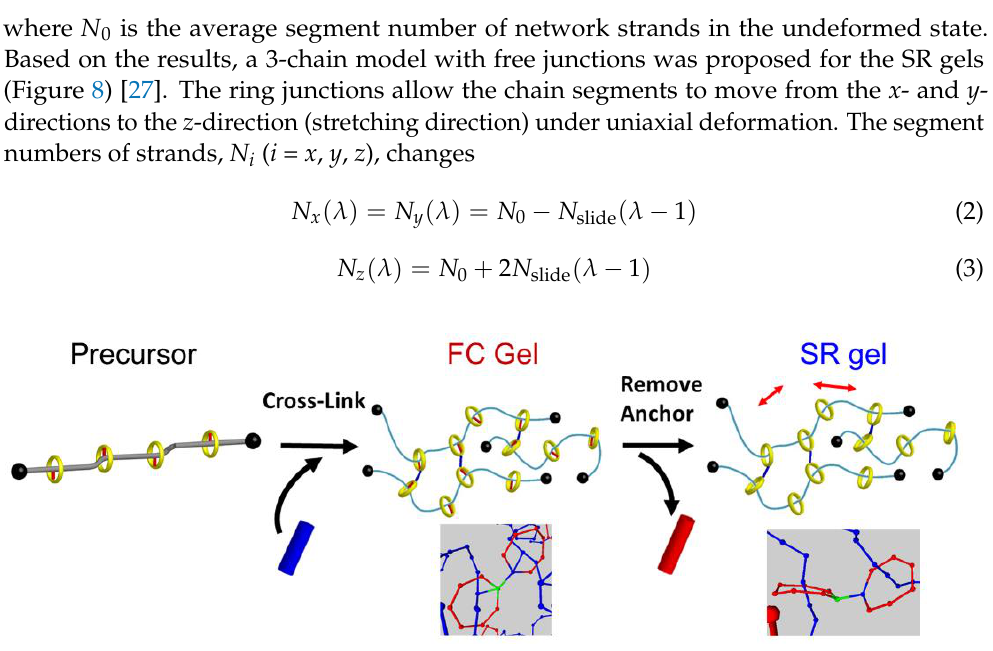
Figure 4. Schematic illustration of coarse–grained models for FC and SR gels. Reprinted from [27] with permission from American Chemical Society.